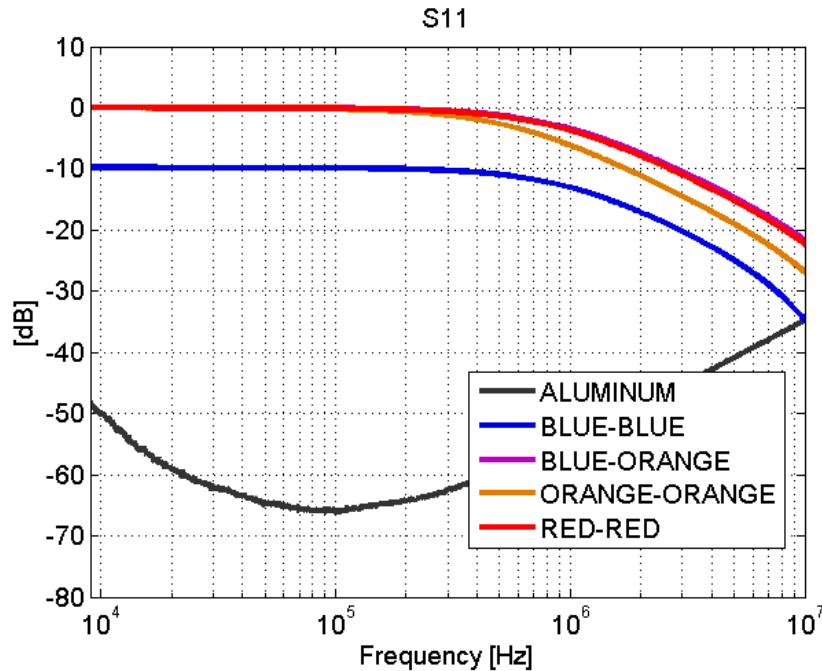
Figure 8. Scattering parameters test: S 11 . Adhesive